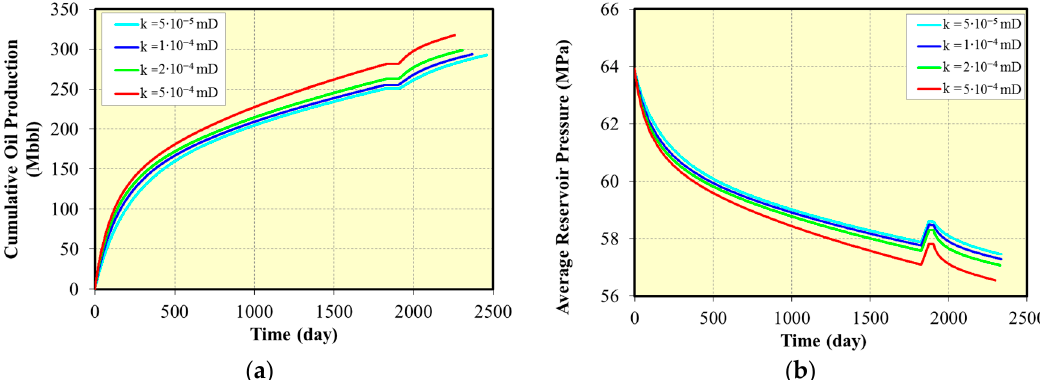
Figure 10. Effect of different matrix permeability with one huff-n-puff cycle on oil production and reservoir pressure: ( a ) Cu- mulative oil production for different matrix permeability; ( b ) Average reservoir pressure for different matrix